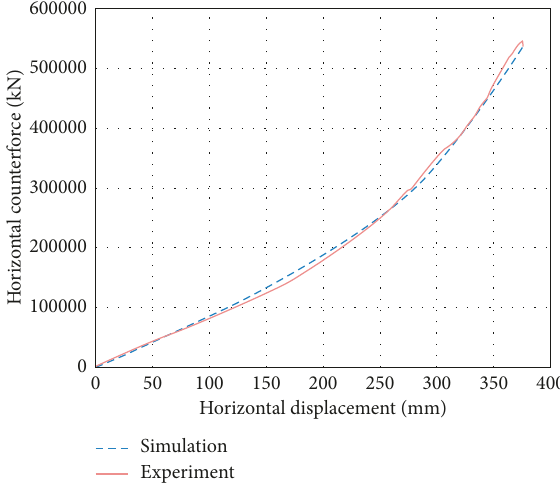
Figure 30: Comparison of horizontal reaction force—horizontal displacement relationship